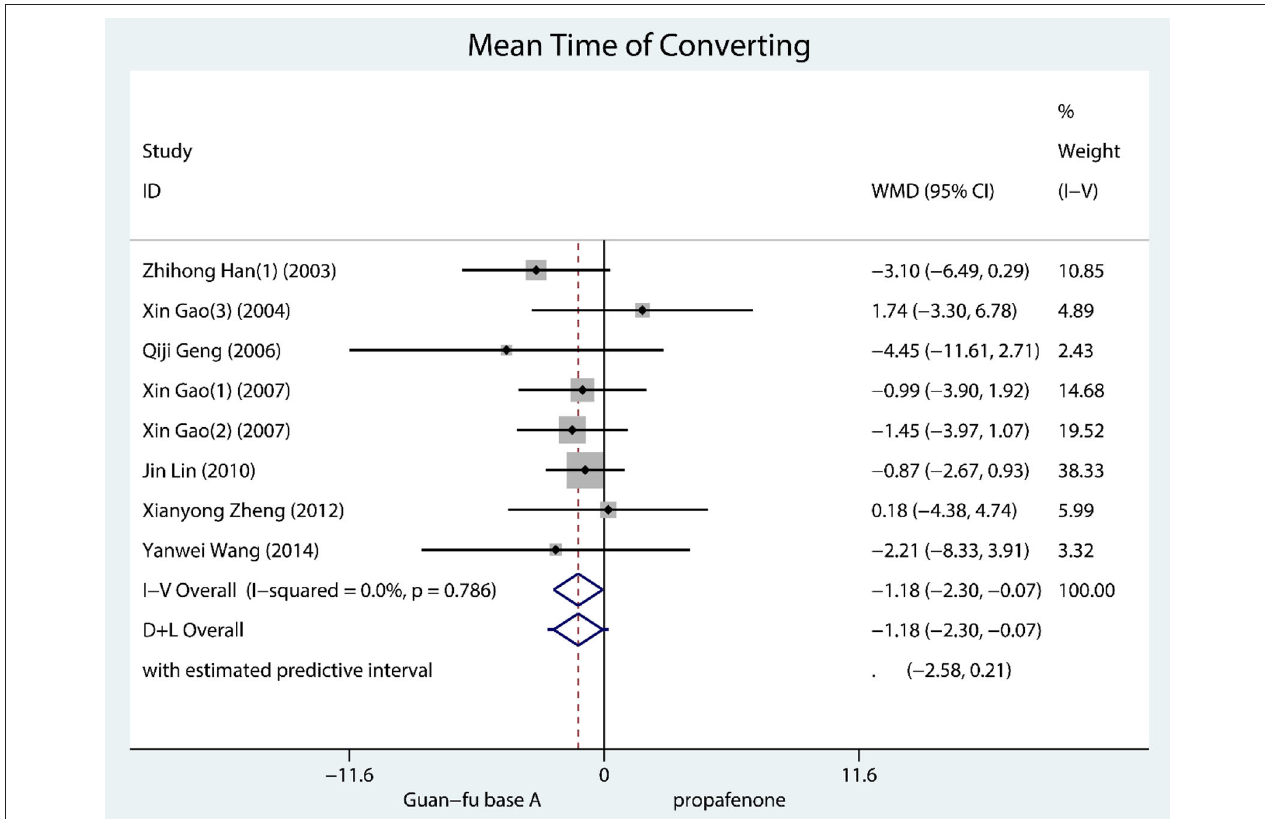
FIGURE 5 | Forest plot comparing the GFA with propafenone in mean converting